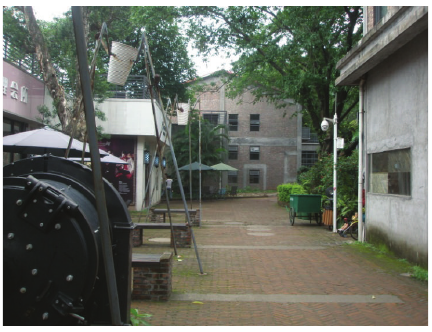
Figure 11: One view of T.I.T